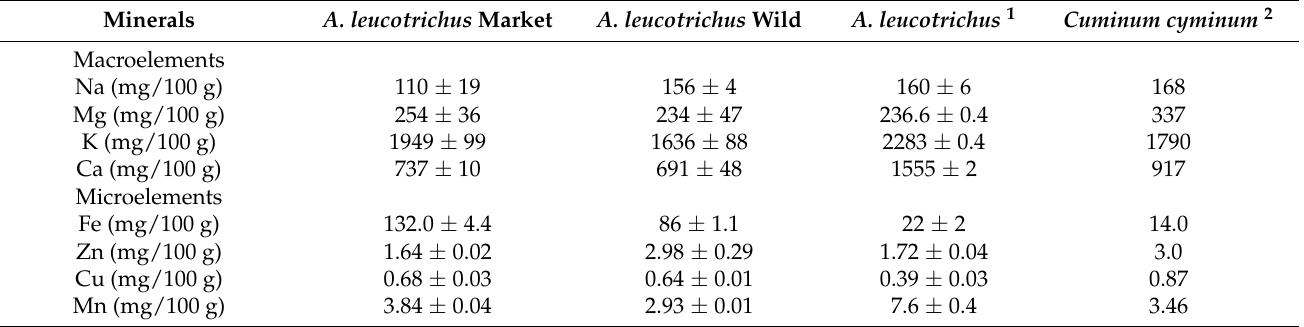
Table 2. Mineral determination of A. leucotrichus samples compared to literature data for A. leu- cotrichus and C. cyminum